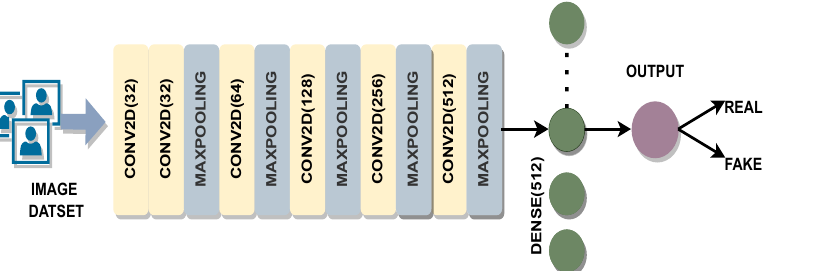
Figure 2. Custom CNN Model: A custom CNN model was trained on CASIA, Replay Attack and SiW training sets for the evaluation using each respective test